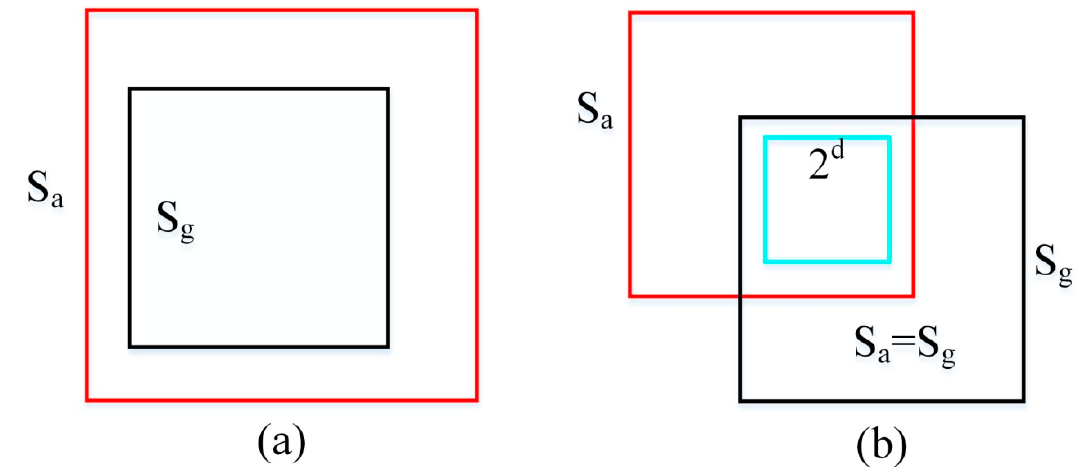
Figure 4. Two extreme cases between anchor box and ground truth box. ( a ) The ground truth box is right in the anchor box ( b ) The center of the anchor box is in the upper left corner of the grid cell and the center of the ground truth box is in the bottom right corner of the grid cell.